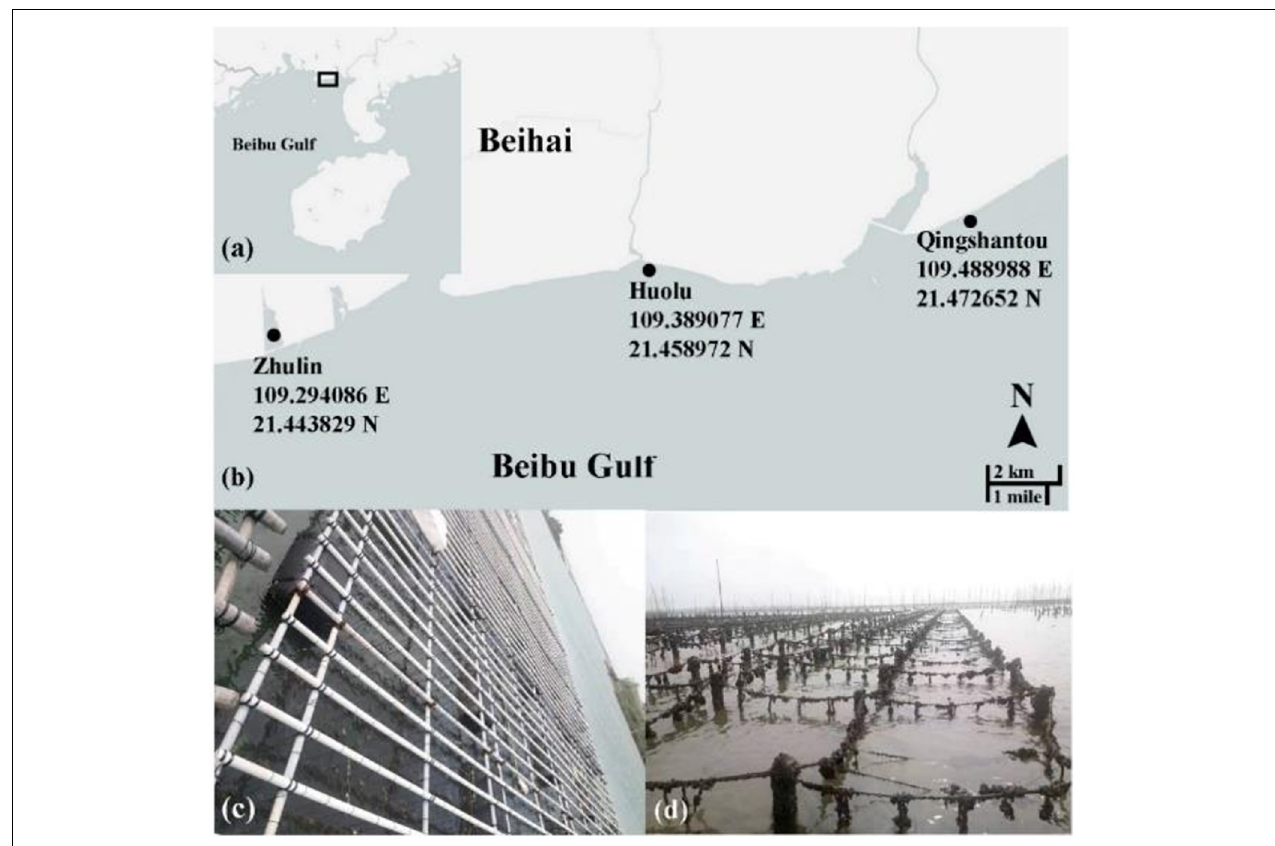
FIGURE 2 | Culture sites and methods. (a,b) The three culture sites used in this study; (c) oyster hanging culture at Zhulin; (d) oyster off-bottom cultures at Huolu and